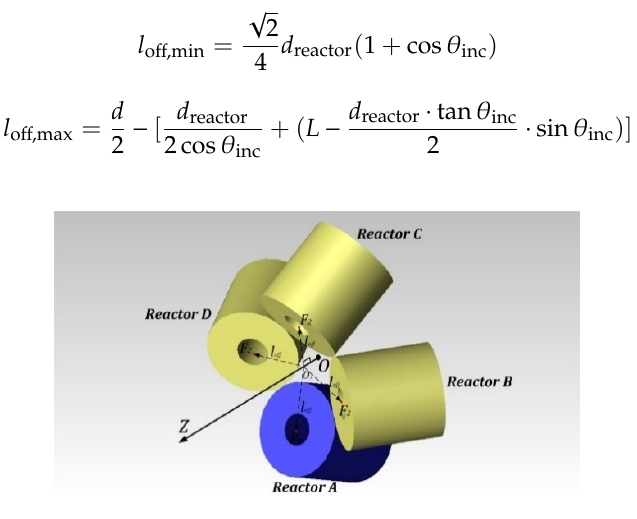
Figure 3. Sketch of multi-cavity receiver-reactor array. Mechanical configuration is neglected here.